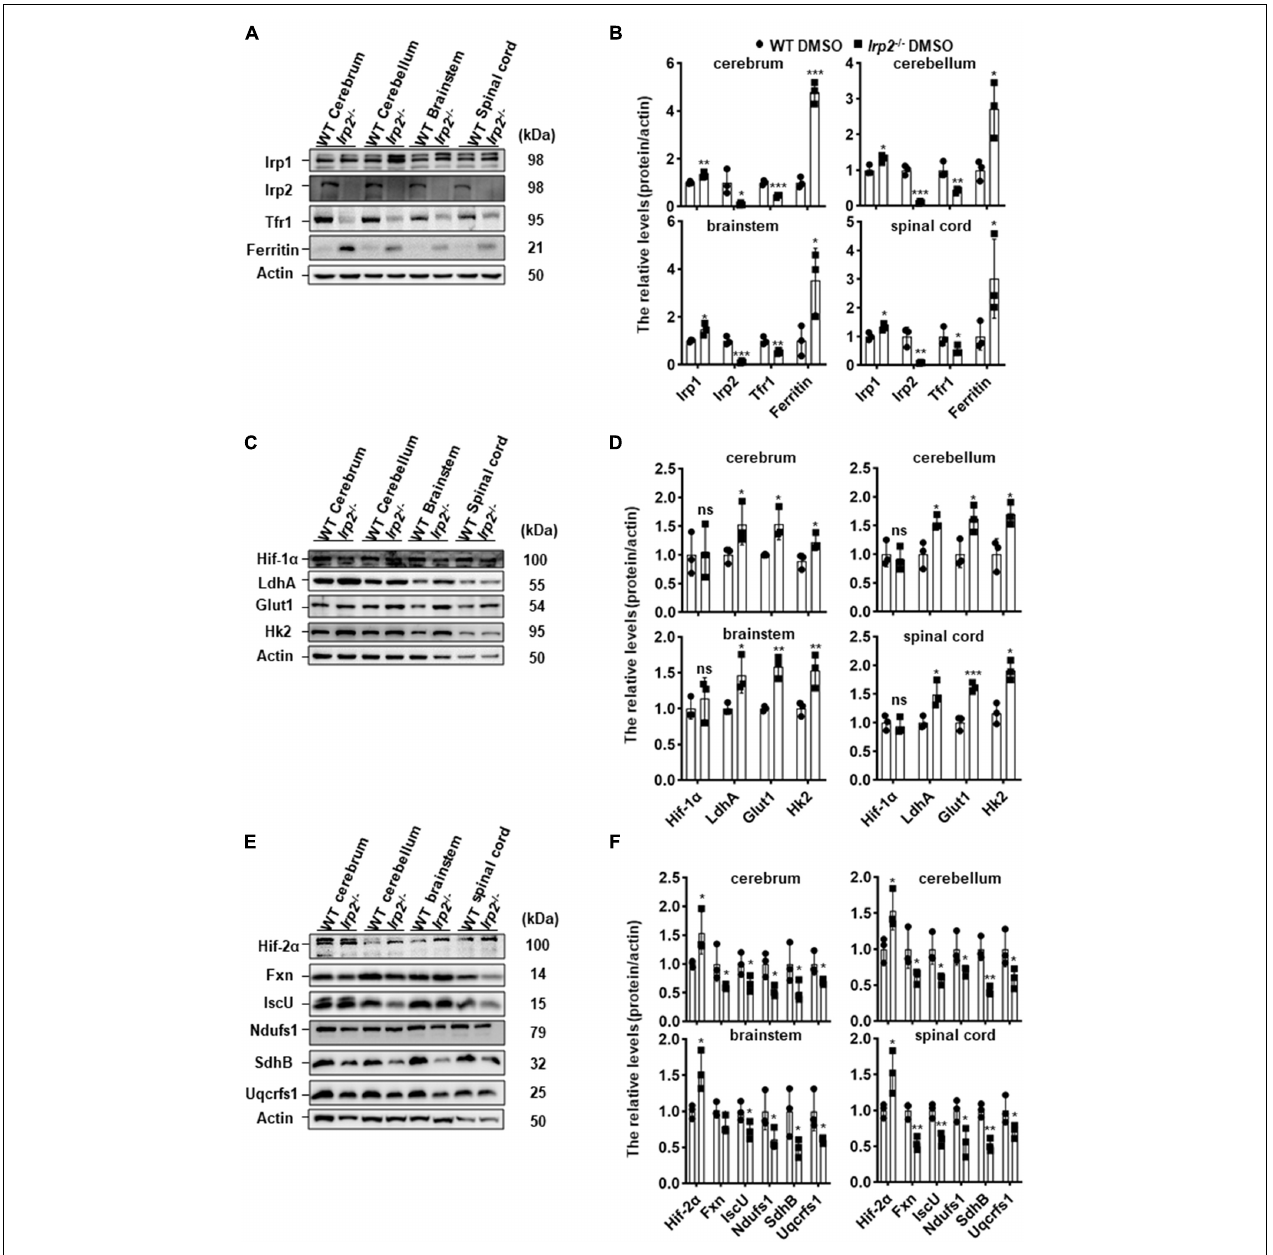
FIGURE 1 | Irp2 ablation enhances glycolysis-related gene expression and diminishes oxidative phosphorylation (OXPHOS)-related gene expression in the tissues of the CNS, analyzed by western blots. (A) Protein levels of iron-related genes ( Irp1 , Irp2 , Tfr1 , and ferritin) in central nervous tissues (cerebrum, cerebellum, brainstem, and spinal cord) of wild-type (WT) and Irp2 − / − mice. (B) Quantification of the band intensity for panel (A) . (C) Protein levels of hypoxia-inducible factor 1 α (Hif-1 α ) and glycolytic pathway-related proteins (Glut1, Hk2, and LdhA) in central nervous tissues (cerebrum, cerebellum, brainstem, and spinal cord) of WT and Irp2 − / − mice. (D) Quantification of the band intensity for panel (C) . (E) Protein levels of hypoxia-inducible factor 2 α (Hif-2 α ), Fe–S biogenesis-related genes (Fxn and IscU), and mitochondrial complex subunits (Ndufs1 for complex I, SdhB for complex II, and Uqcrfs1 for complex III). (F) Quantification of the band intensity for panel (E) . Actin was used as a loading control. Values represented as the mean ± SD ( n = 3), and Student’s t -test was used for statistics to evaluate the group differences. In panels (B,D,F) , * P < 0.05, ** P < 0.01, *** P < 0.001, ns P > 0.05, Irp2 − / − mice vs. WT